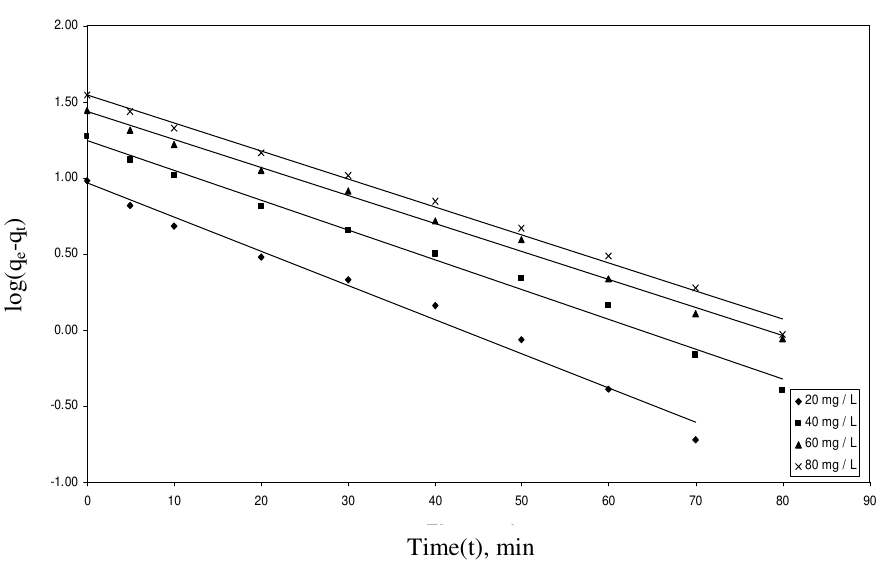
Figure 3. Effect of pH on methylene blue adsorption